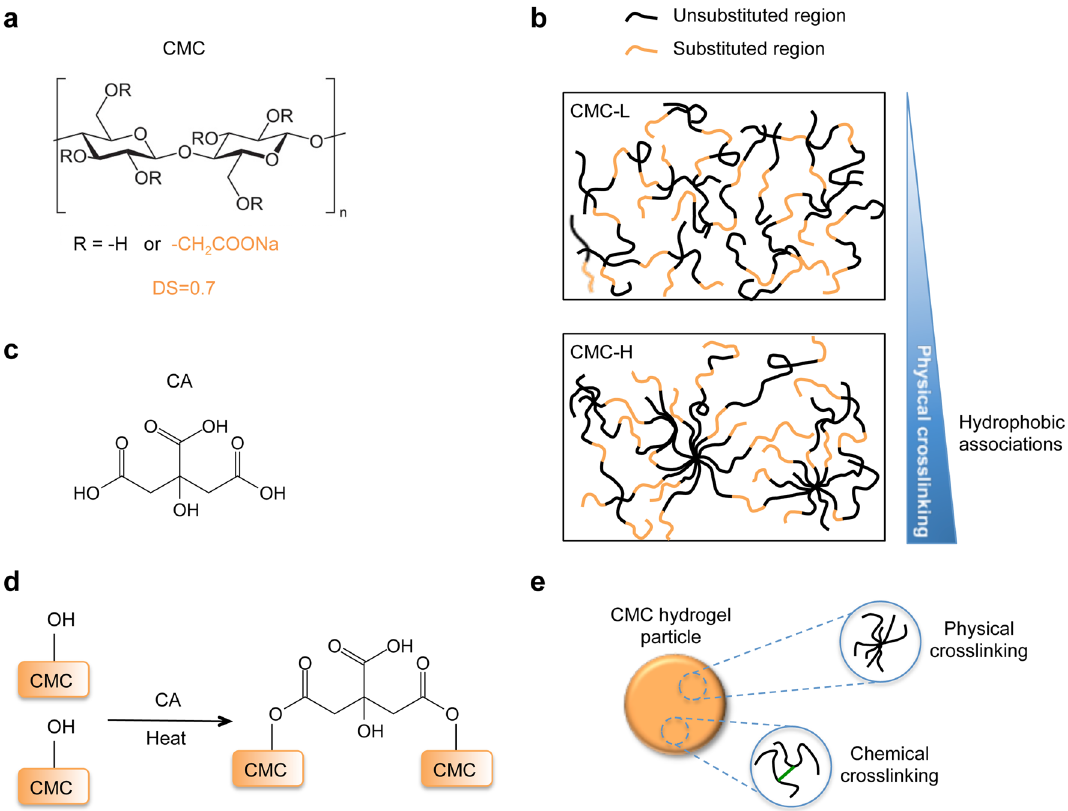
Figure 2. Preparation of stable CMC networks by the combination of physical and chemical crosslinking. ( a ) Chemical structure of the CMC repetitive unit; two CMCs with DS = 0.7 were used in this work, i.e. CMC-L and CMC-H. ( b ) CMCs with DS ≤ 1 may form physical crosslinks in concentrated solutions, due to the establishment of hydrophobic associations among the unsubstituted cellulose blocks; based on its higher molecular weight and higher thixotropy, CMC-H is expected to form a more entangled structure than CMC-L (at fixed concentration). ( c ) Chemical structure of CA and ( d ) esterification reaction with the CMC; the reaction is activated by heat and occurs upon preliminary casting and drying of a CA/CMC solution. ( e ) Presence of both physical and chemical crosslinks in the final CMC